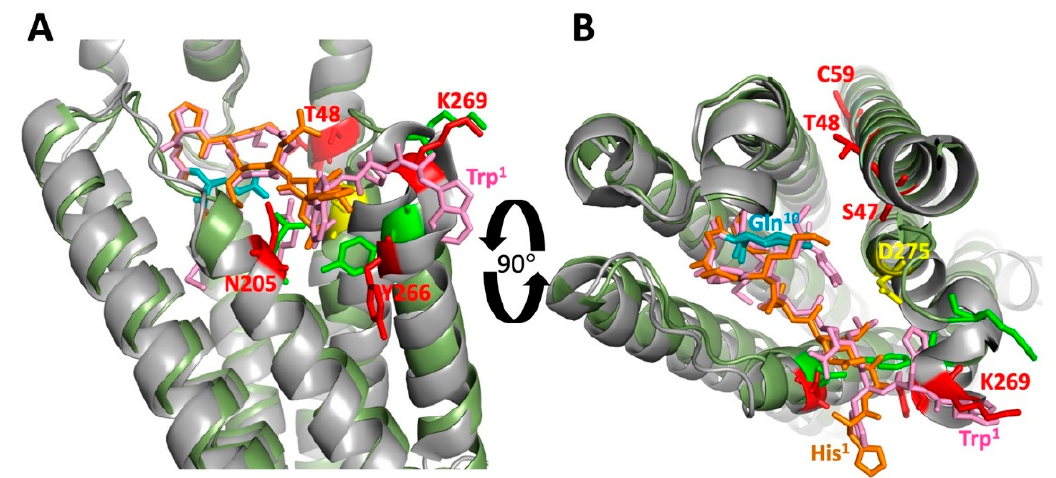
Figure 6. Locations in the three-dimensional structure of α -factor interactions with Ste2p identified in genetic and biochemical experiments. Panels ( A , B ) show views rotated 90 degrees with respect to each other. The antagonist-bound structure (PDB Code: 7QA8) is shown with the protein in cartoon representation in grey, and the antagonist in stick representation in orange. The agonist bound receptor-G protein complex is shown with the protein in olive green and α -factor in pink. Six residues in the protein that were previously reported to interact with the ligand are shown in stick representations in red (antagonist bound state) and green (agonist bound state; but only shown for residues N205, Y266, and K269, which change position between the agonist- and antagonist-bound structures). Residue Gln 10 of the ligands is colored teal. Residue D275, proposed to undergo electrostatic interactions with bound agonist, is shown in yellow. The agonist- and antagonist-bound structures were superimposed using the “align” function of the PyMOL Molecular Graphics System (Schrödinger, LLC). In panel ( B ), the overlying regions of the receptor N-termini have been removed for clarity. The figure also clearly shows the altered position of residue Y266 in comparing the antagonist- vs. the agonist-bound receptor conformations, and the steric clash that would occur between Trp 1 of α -factor and the extracellular end of TM6 in attempting to dock α -factor into the antagonist-bound conformation. It also shows that residue His 1 of the bound antagonist occupies nearly the same position occupied by Trp 3 of bound α -factor, a position ~9 Å removed from the position of the corresponding His 2 residue of bound α -factor [37].